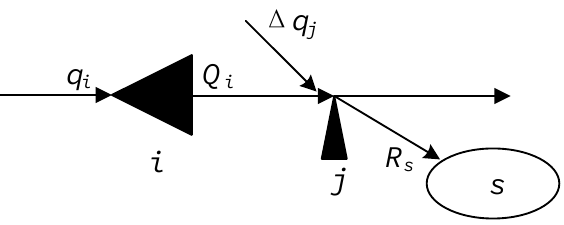
Figure 1. The skeleton diagram of the sub flood control system.